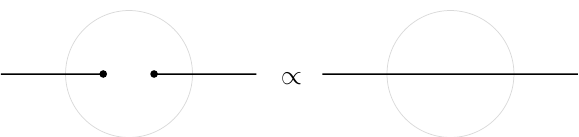
Figure 19 . The OPE of a pair of weight-(0 ; 0) topological defect operators in V L 0 gives the simple TDL L 0 .